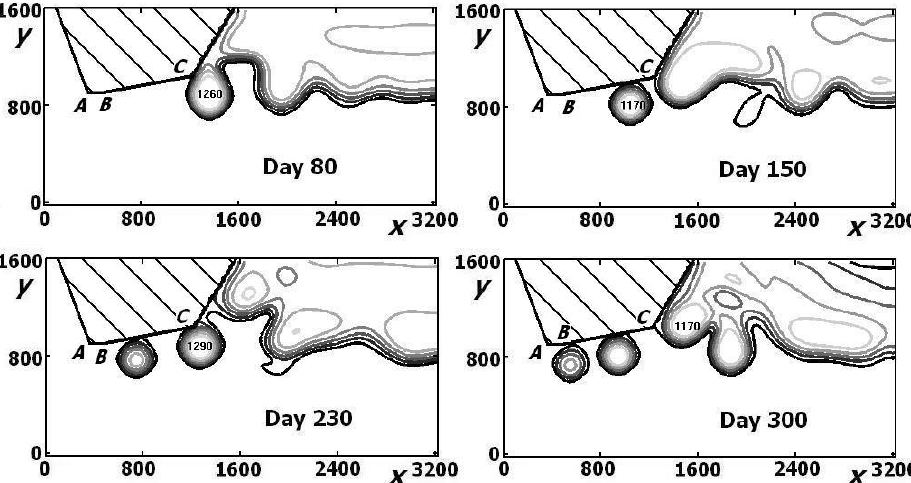
Fig. 9. Upper layer thicknesses for the case of a Concave III coastline and a modest vorticity current that retroflects near the kink ( α = 0 . 4, h 0 = 0, ν = 1000m 2 s − 1 , and β = 6 × 10 − 11 m − 1 s − 1 ). This case is representative of SIF times, when the Agulhas retroflection is shifted eastward.